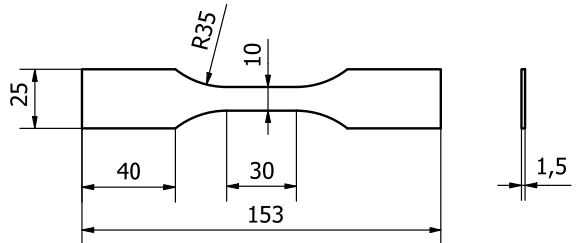
( b ) Figure 4. Test stand: ( a ) Instron 5966 testing machine, ( b ) tensile test and specimens in holders. 2.2.2. Tests of Mechanical Properties of Adherend Materials